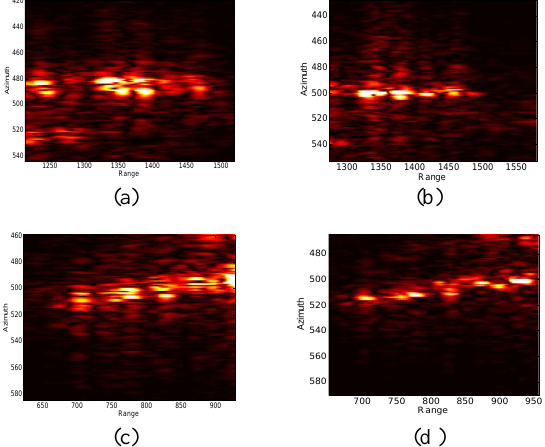
Figure 4 partial enlarged drawings; image (a) and (c) are right wing and left wing obtained by the original method; image (b) and (d) are obtained by modified method